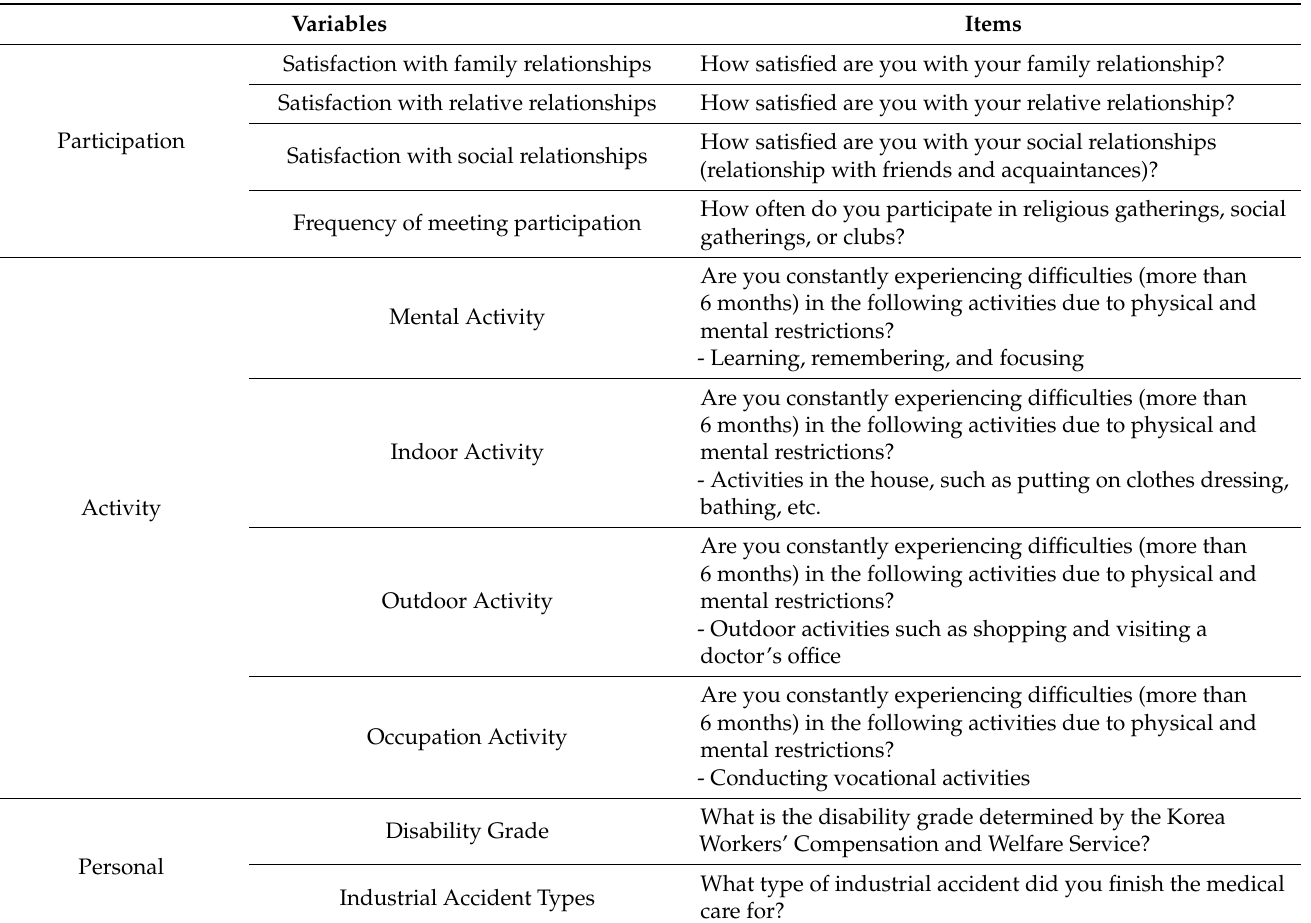
Table 2. Variable measurement